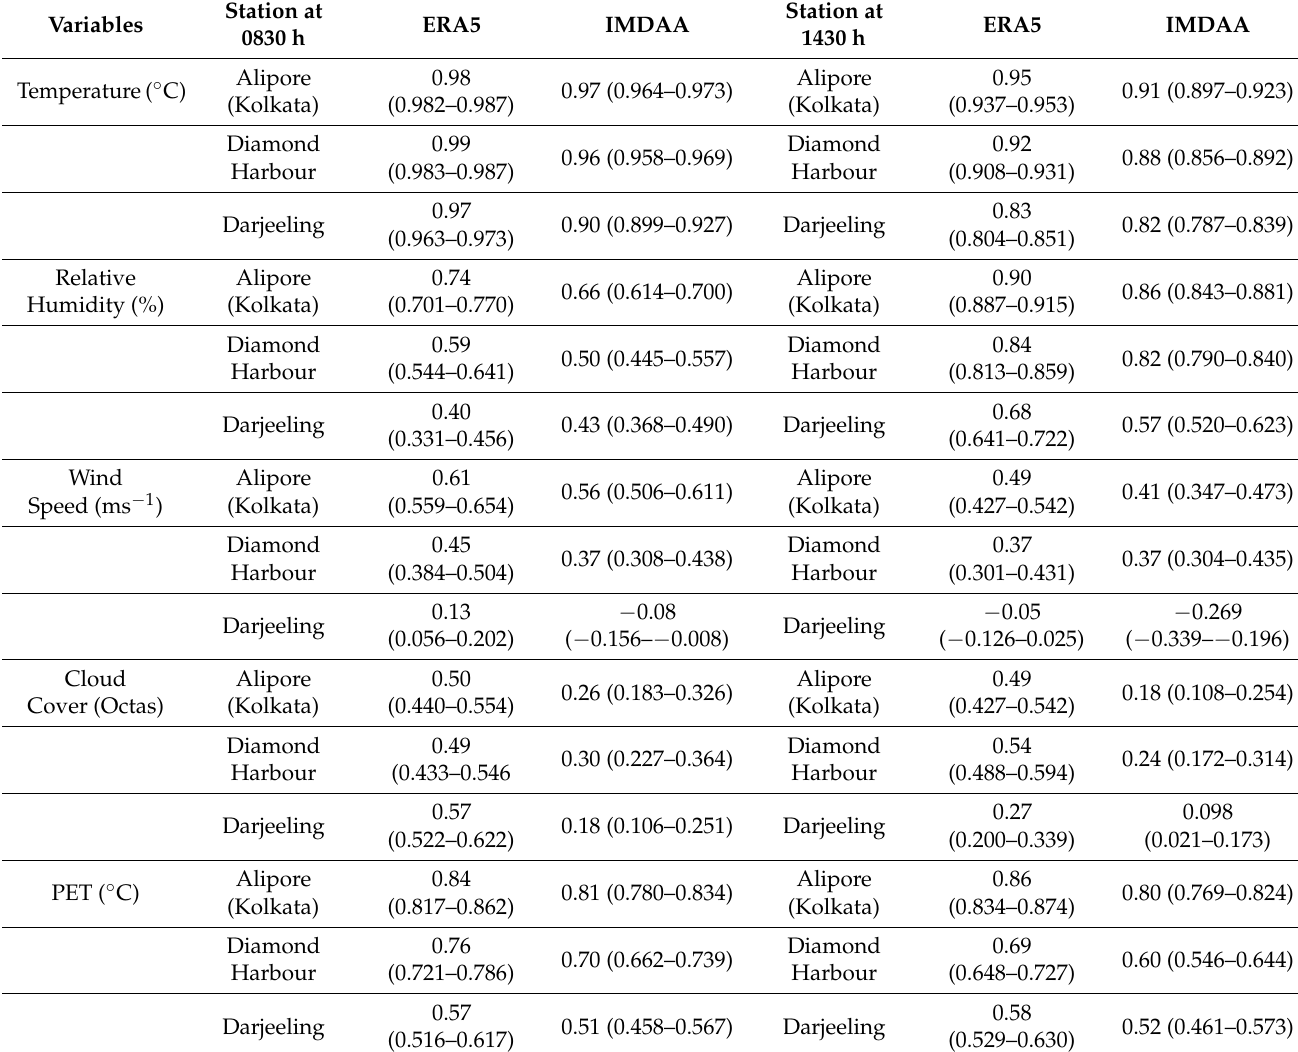
Table 5. Correlation coefficient values for air temperature, relative humidity, wind speed, cloud cover, and PET variables from ERA-5 and IMDAA against observed data measured by IMD. The period of analysis is over daily data from January 2020 to December 2021 at 0830 h (IST) and 1430 h